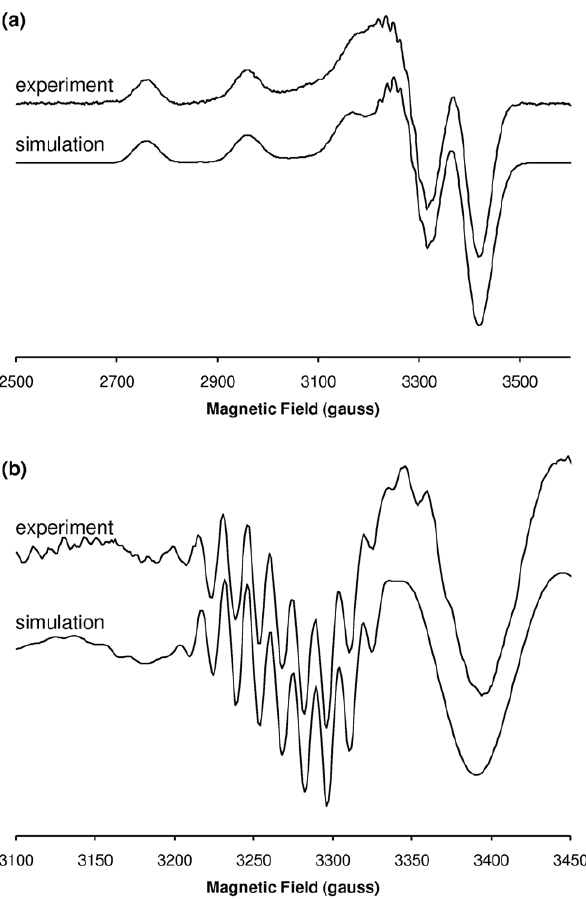
Figure 6. Simulation of the X-band CW-EPR spectrum of Cu 2 + / A b 3[pE]–16 at pH 6.9. (a) First derivative. (b) Second derivative, expanded around g H region. Simulation parameters appear in Table 2.